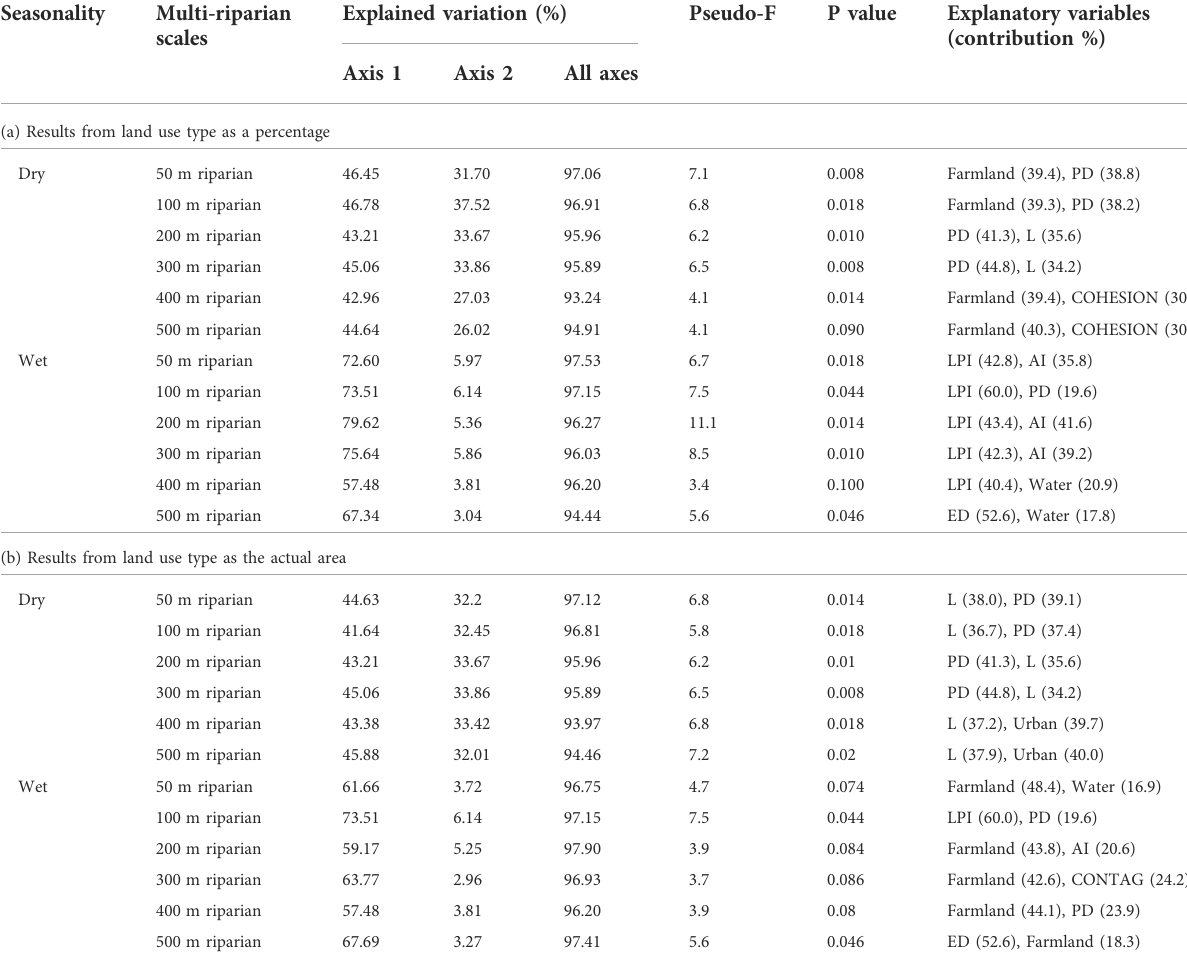
TABLE 2 RDA results for the overall water quality variance explained by the explanatory variables (explanatory variables include the percentage of land use types, TA, NP, PD, LPI, ED, LSI, CONTAG, COHESION, AI, SHDI, and L). Seasonality Multi-riparian Explained variation (%) scales